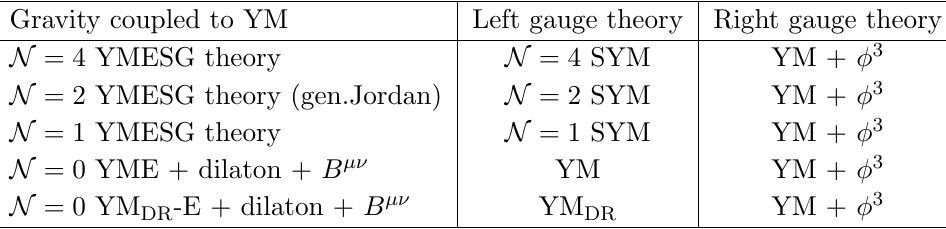
Table 1 . The double-copy constructions that appeared in ref. [27]. These give amplitudes in YME gravity theories for various amounts of supersymmetry, corresponding to di(cid:11)erent choices of the left gauge theory. The right theory labeled by YM + (cid:30) 3 corresponds to the YM + scalar theory with N f 0. The = 1 YMESG theory is a particular truncation of a generic Jordan family ! N = 2 YMESG theory in which the scalar and one fermion is dropped from every nonabelian vector N multiplet together with the vector (cid:12)eld and one of the gravitini in the graviton multiplet. The last row corresponds to dimensional reductions of a higher-dimensional left gauge theory; this row has the same bosonic content as the previous cases, given that the original theory lived in D = 10 ; 6 ; 4 ; 4 dimensions,